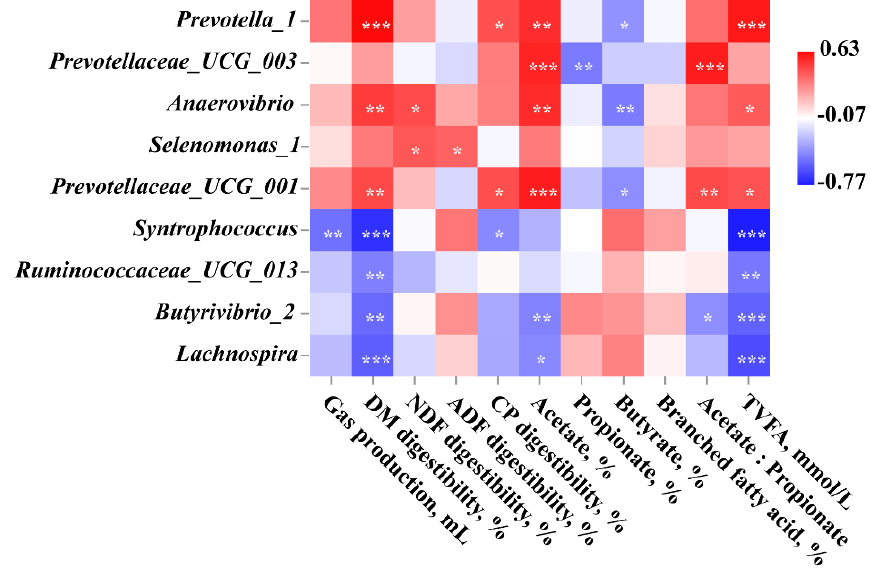
Figure 9. Spearman correlation between the relative abundance of genus features and phenotypic indices. Genus features obtained using Linear Discriminant Analysis Effect Size analysis from AOAN vs. CON. AOAN indicated feed fermentation with Aspergillus oryzae and Aspergillus niger co-cultivation fermentation extract. CON group indicates all feeds without AOAN supplementation. AOAN group indicates all feeds with AOAN supplementation. The color represents the correlation coefficient. Red represents a positive correlation, and blue represents a negative correlation. A dark color represents a stronger correlation, and a light color represents a weaker correlation. *, 0.01 < p < 0.05; **, 0.001 < p < 0.01; ***, p ≤ 0.001; DM, dry matter; CP, crude protein; NDF, neutral detergent fiber; ADF, acid detergent fiber; TVFA, total volatile fatty acid.